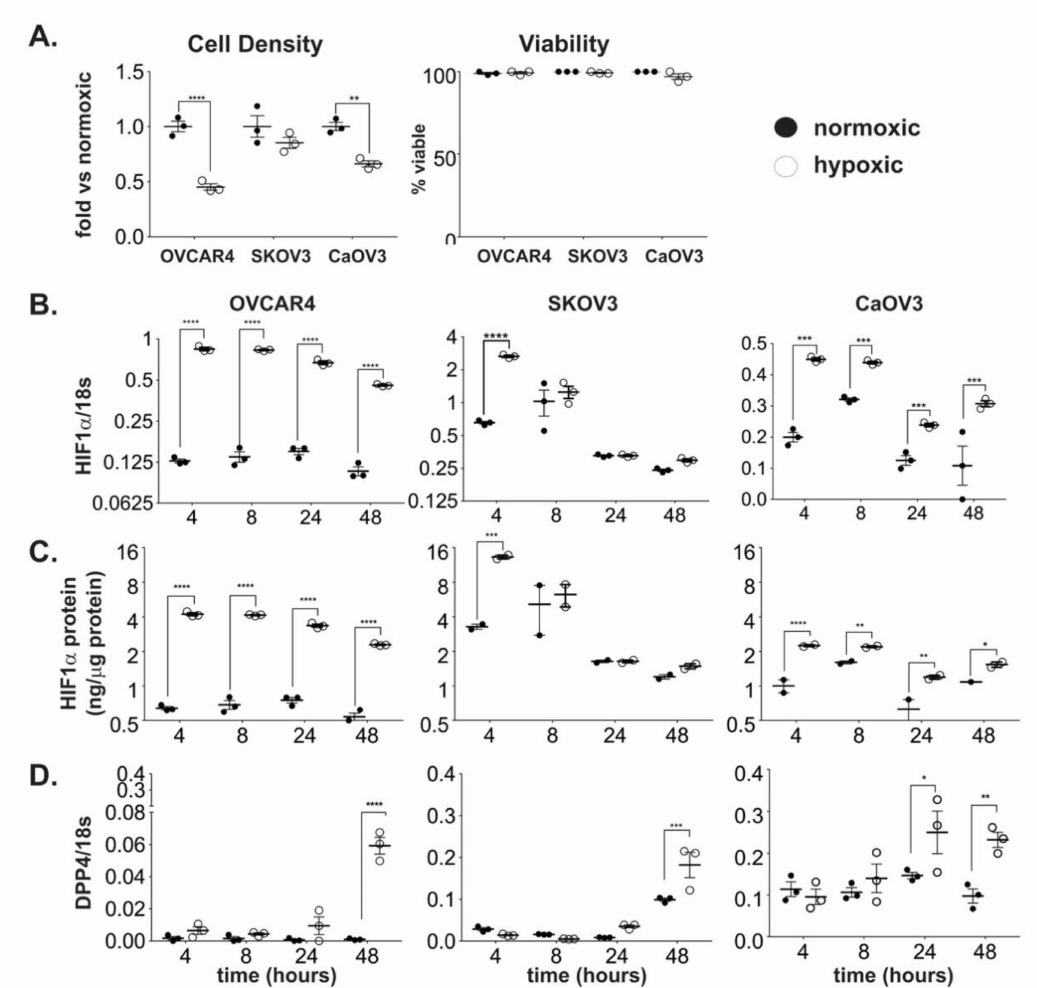
Figure 1. The e ff ect of hypoxia on cell growth, HIF-1 α and DPP4 expression in ovarian cancer cells. Ovarian cancer cell lines OVCAR4, SKOV3, and CaOV3 were seeded at ~10 6 cells / 25 cm 2 flask and cultured under normoxic or hypoxic conditions for up to 48 h. ( A ) Cell density and viability at 48 h. ( B ) HIF-1 α mRNA expression and ( C ) protein abundance were measured by qRT-PCR and ELISA respectively. ( D ) DPP4 mRNA expression was measured by qRT-PCR. Data represent the mean ± SD, n = 3 / group. * p < 0.05; ** p < 0.01; *** p < 0.001; **** p <